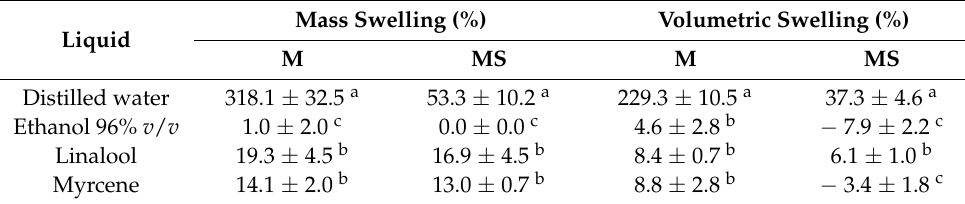
Table 4. Mass and volumetric (thickness) swelling degree of the PET-supported (MS) and the non-supported (M) membranes after 24 h of exposure to distilled water, ethanol 96% vol., linalool, and myrcene. Mass Swelling (%) Volumetric Swelling (%) Liquid M MS MS Distilled